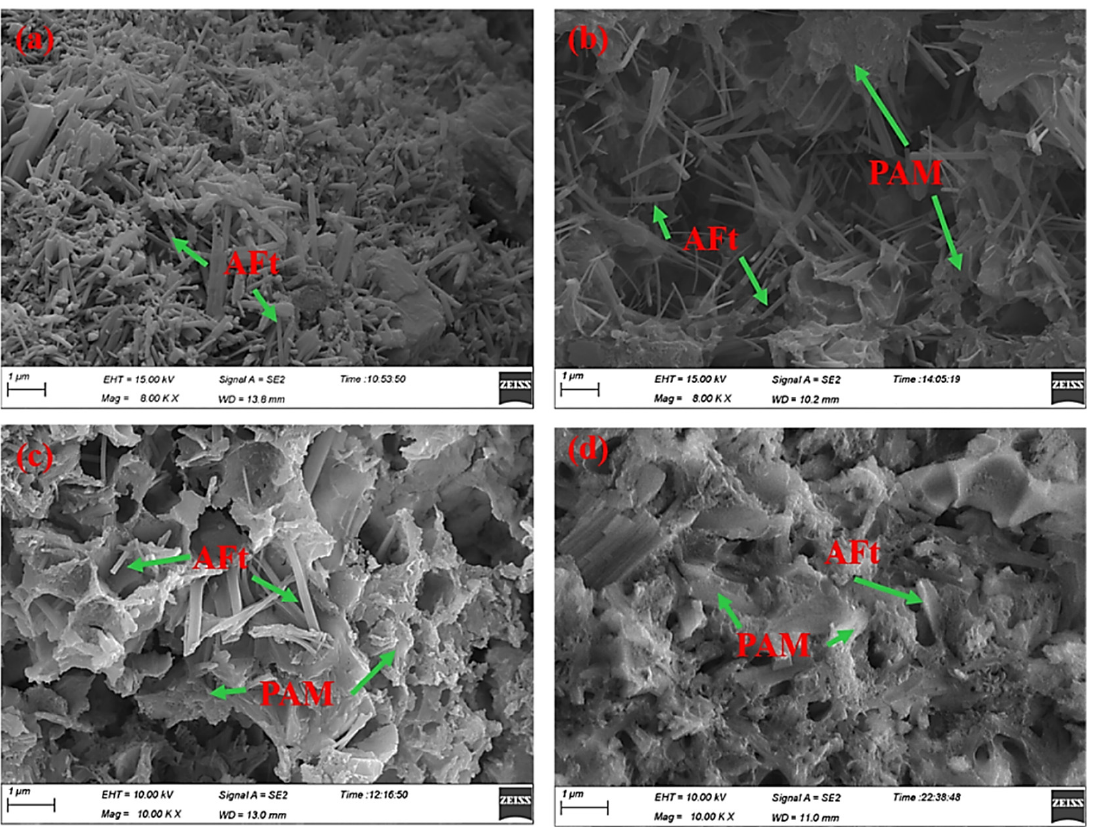
Figure 17. SEM photos of 28 d specimens: ( a ) 0% PAM; ( b ) 15% PAM; ( c ) 25% PAM; ( d ) 35%PAM.